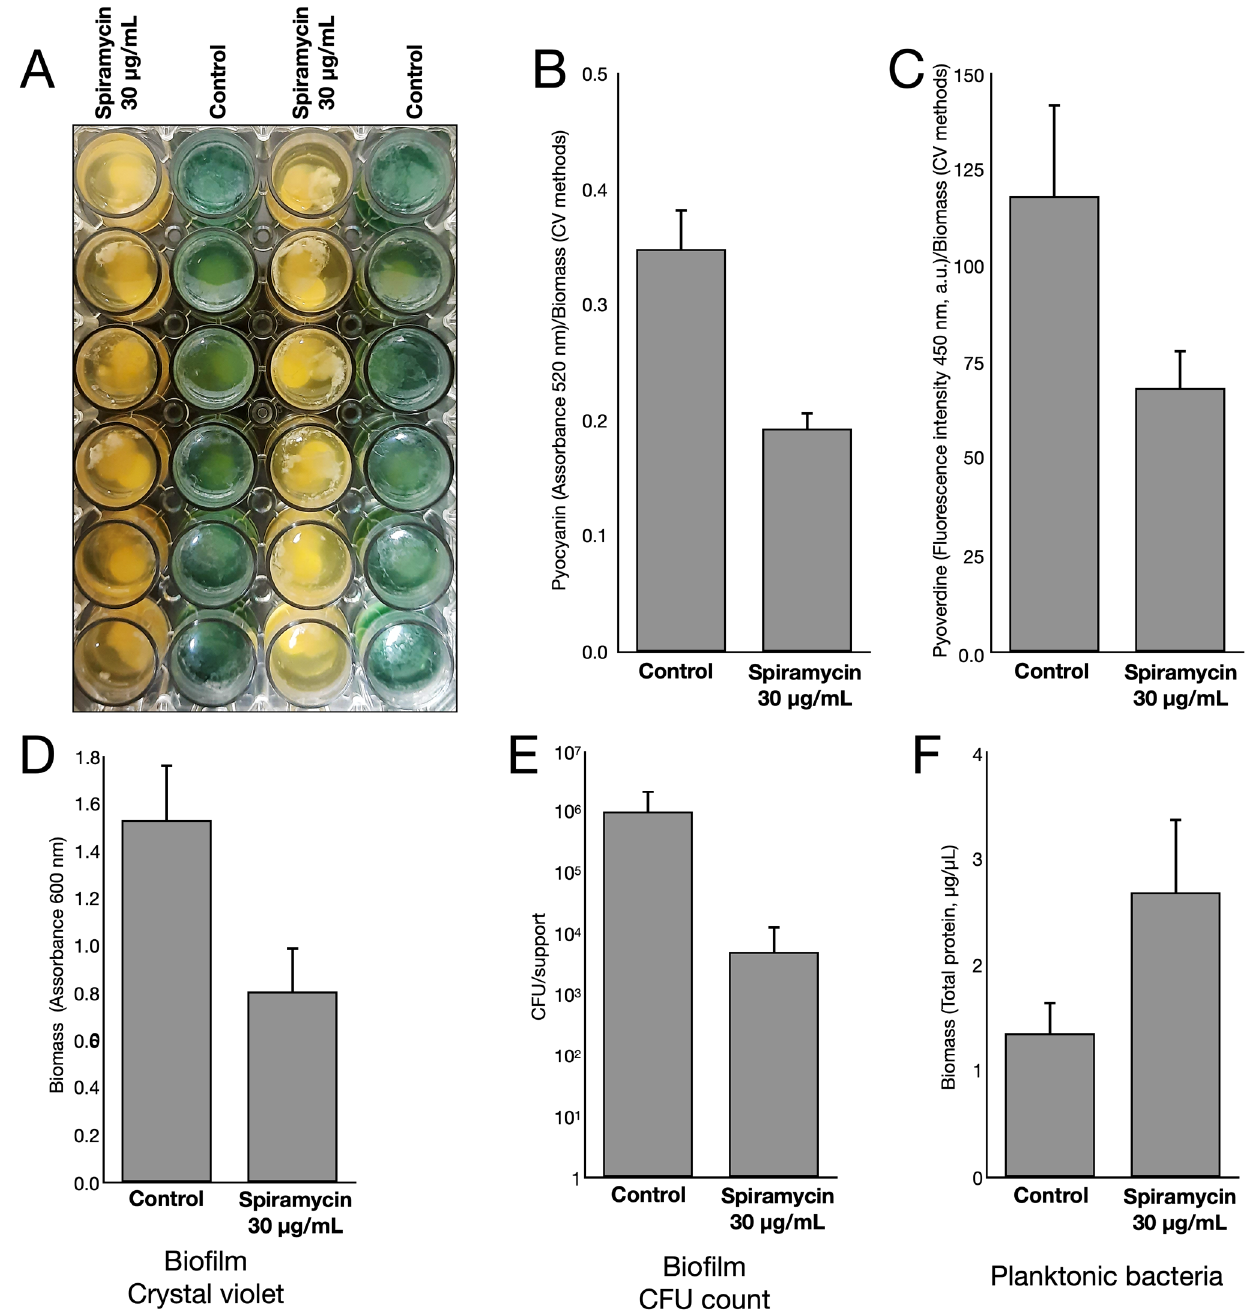
Figure 6. Effects of spiramycin on growth, biofilm, PYO, and PVD production by P. aeruginosa GG-7R growing on hydroxyapatite surfaces in multi-well plate filled with LB. ( A ) View of the plate after 72 h of incubation (37 °C, 150 rpm). ( B ) PYO quantification (optical absorbance at 520 nm) normalized by the biomass measured by the CV method. ( C ) PVD quantification (excitation at 405 nm, emission at 450 nm) normalized by the biomass measured by the CV method. ( D,E ) Estimation of the biomass using Crystal Violet method ( D ) or CFU counts ( E ). ( F ) Biomass of planktonic bacteria estimated by absorbance at 600 nm.